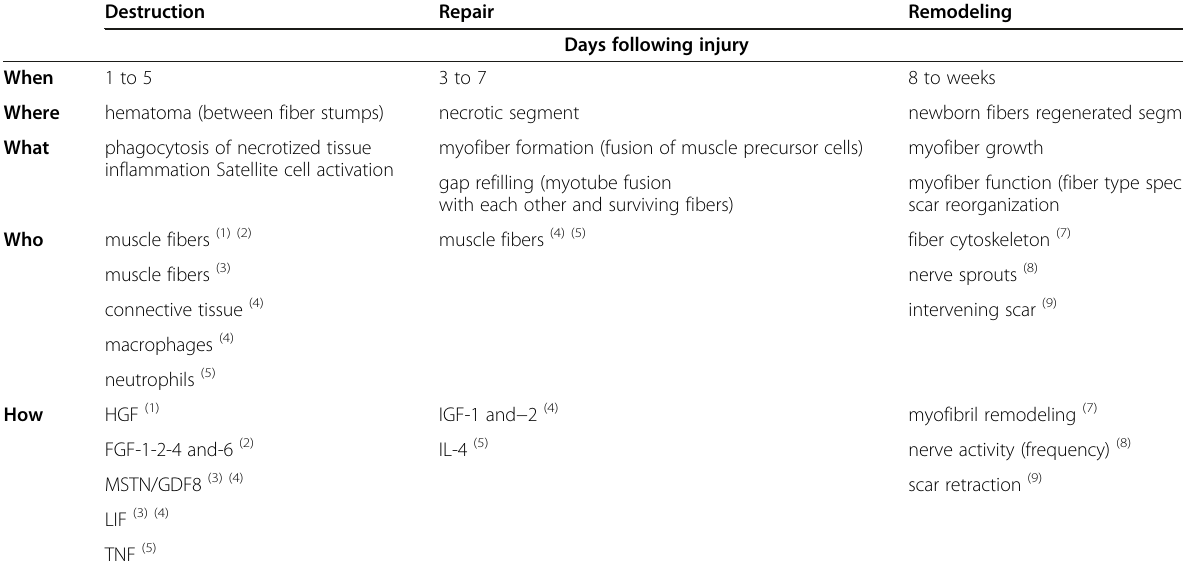
Table 3 Kinetics of wound healing of the muscle: main phases and players Destruction Repair Remodeling Days following injury 3 to